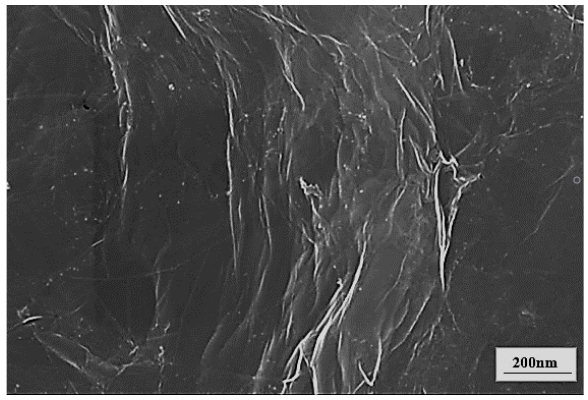
Figure 6. SEM characterization of GO.